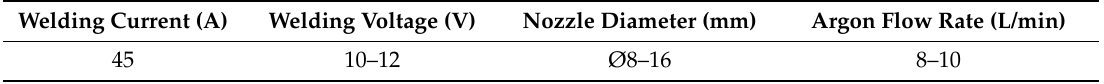
Table 1. Specific welding parameters in this